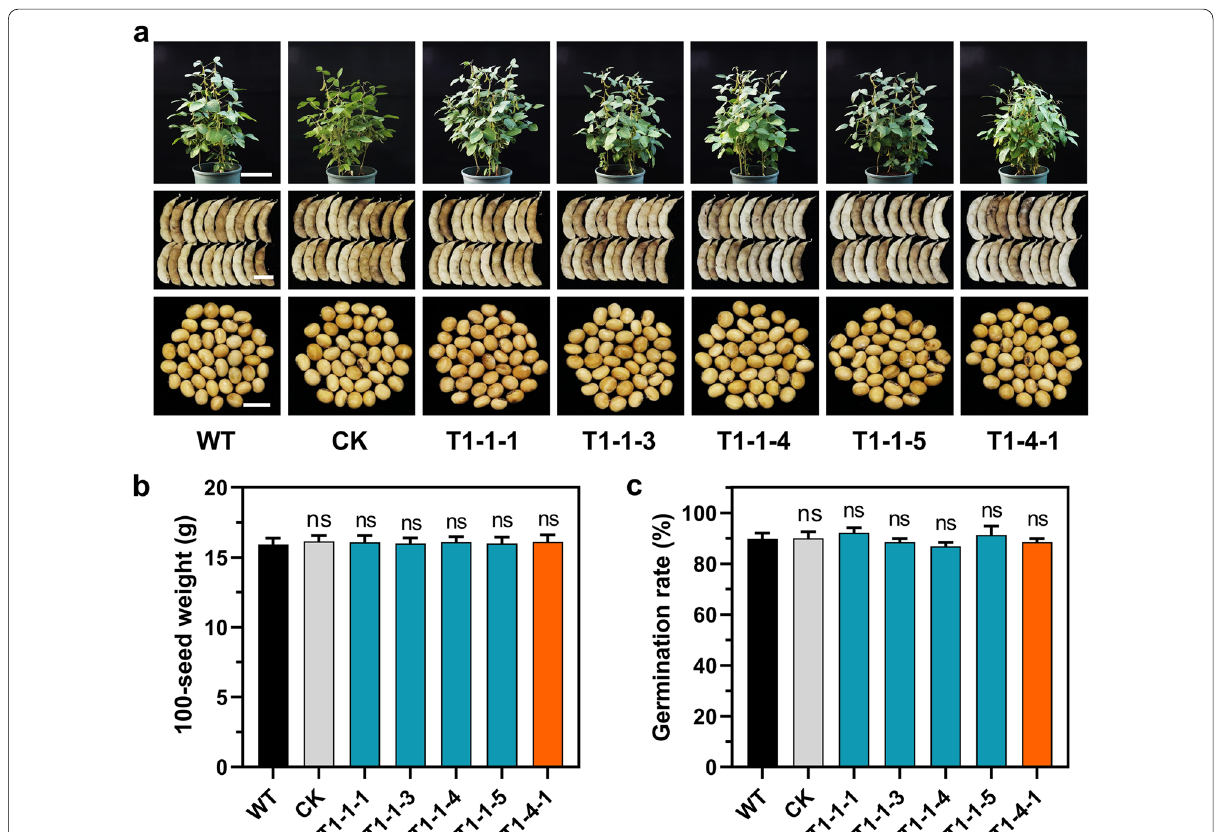
Fig. 7 Agronomic traits of GmPAO overexpression soybean lines. The soybean lines were the same as in Fig. 1. a Growth phenotypes (upper) of soybean plants grown in growth chambers for two months. Scale bar, 20 cm. Pod (middle) and Seed (lower) morphology after harvest. Scale bars, 1 cm. b Statistical analysis of 100-seed weight of the transgenic soybean plants. The seeds were randomly chosen and weighed. Error bar represents mean SD, n 20, n represents sample number. c Germination rate of the transgenic soybean plants. The number of germinated seeds ± = was recorded after gemination for 8 days. Error bar represents mean SD, n 3 experiments with 40 seeds. All the experiments were performed ± = three times (biological replicates) with similar results. The data in b and c were analyzed by Shapiro–Wilk test to determine the Normality and Lognormality Tests across groups, and then analyzed by one-way ANOVA with post-hoc Dunnett’s multiple comparisons test for groups that had passed the normality test (ns, no significant difference). The exact n, SD values, and P values are shown in the